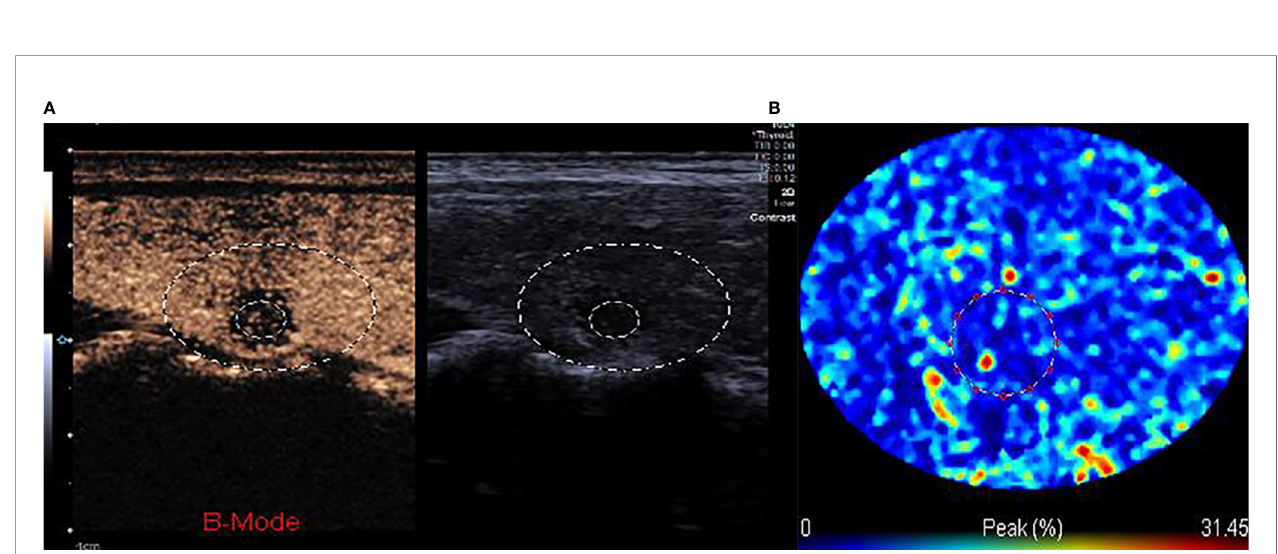
FIGURE 2 | (A, B) The TIC analysis curve of the CEUS image. First, we selected the target area with a large circle, second, we drew the ROI inside the nodule with a small circle. According to the TIC curve in the small circle, we selected the frame corresponding to the moment when internal nodule perfusion reached its